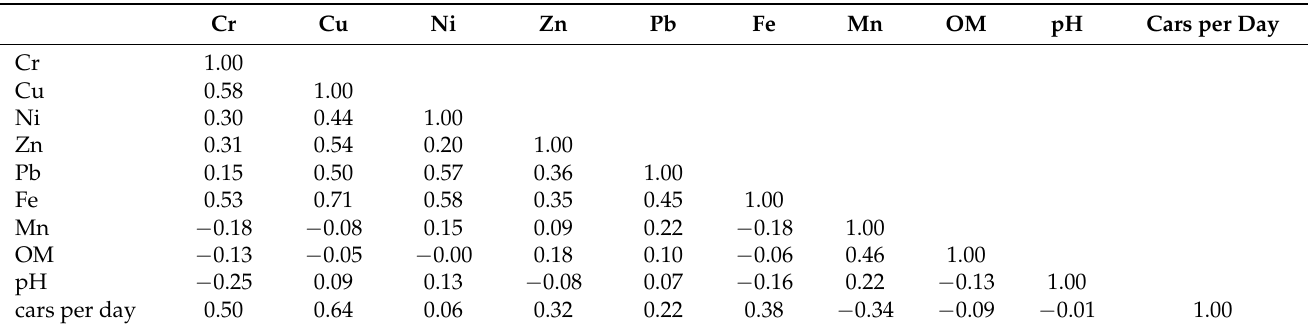
Table 3. Pearson’s correlations matrix for the metal concentrations. Correlation is significant at the 0.05